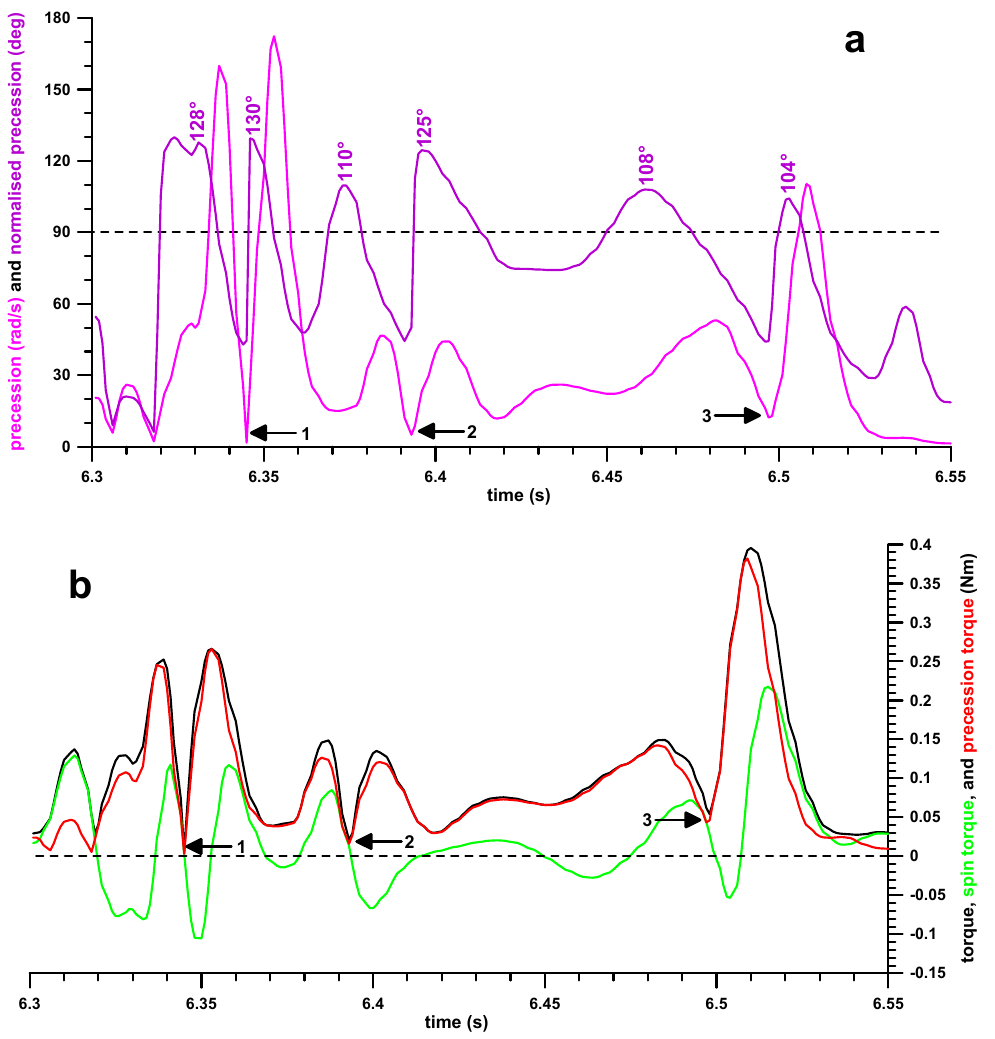
Figure 3. ( a ): precession and normalized precession against the time; ( b ): torques against the time; 1, 2, 3 = change of direction of the spin